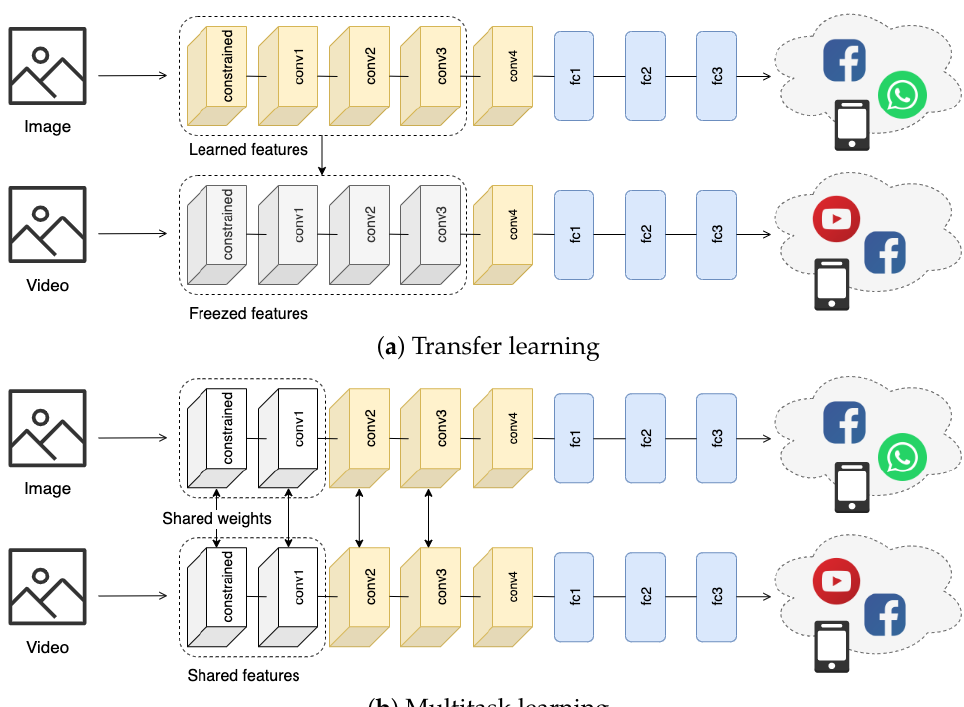
Figure 3. Learning approaches proposed in this paper: ( a ) Method based on transfer learning; ( b ) Method based on multitask learning. In the transfer-learning approach we initially train the model on the image task. Then we reuse the feature representations learned on images to train the model on the video source platform identification task. In multitask learning we share the weights of the constrained and conv1 layers of two siamese networks while learning them on images and videos in